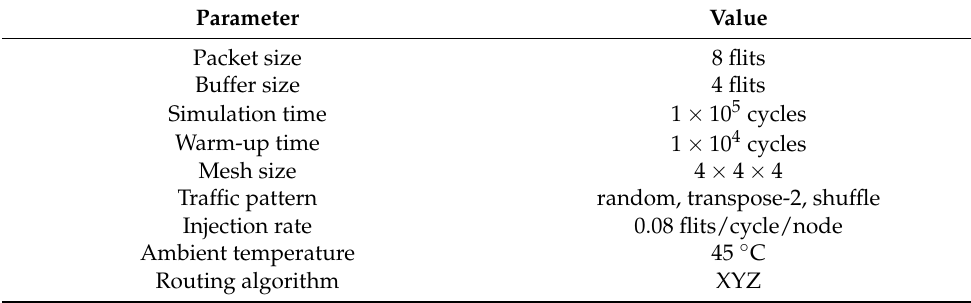
Table 1. Specification of parameters for simulation.